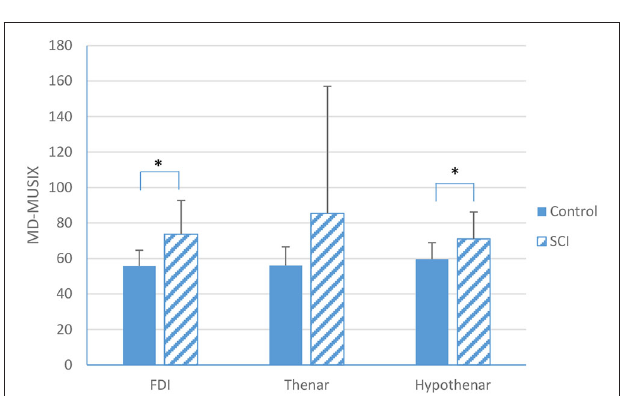
FIGURE 4 | A comparison in MD-MUSIX between SCI and neurologically intact subjects for the FDI, thenar and hypothenar muscles (mean ± standard deviation, *indicates p <